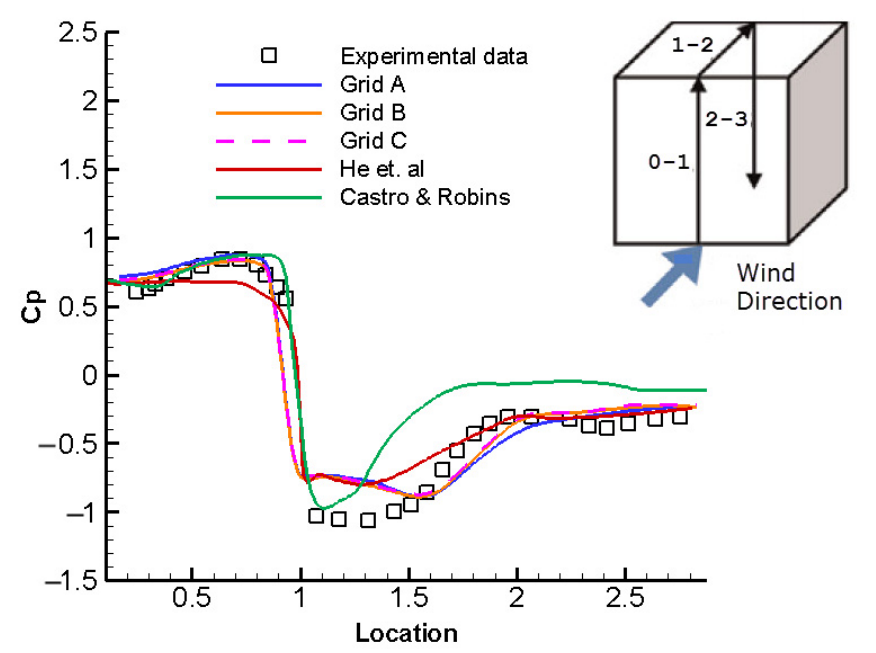
Figure 2. Comparison of the measured mean pressure coefficients calculated for three different grid resolutions with experimental data [31] and numerical results reported by He et al. [30] and Castro & Robins [62]; The measurements were taken on the building centreline shown by the solid line of (0–1–2–3); U ref = 6 m/s (no-fire case).